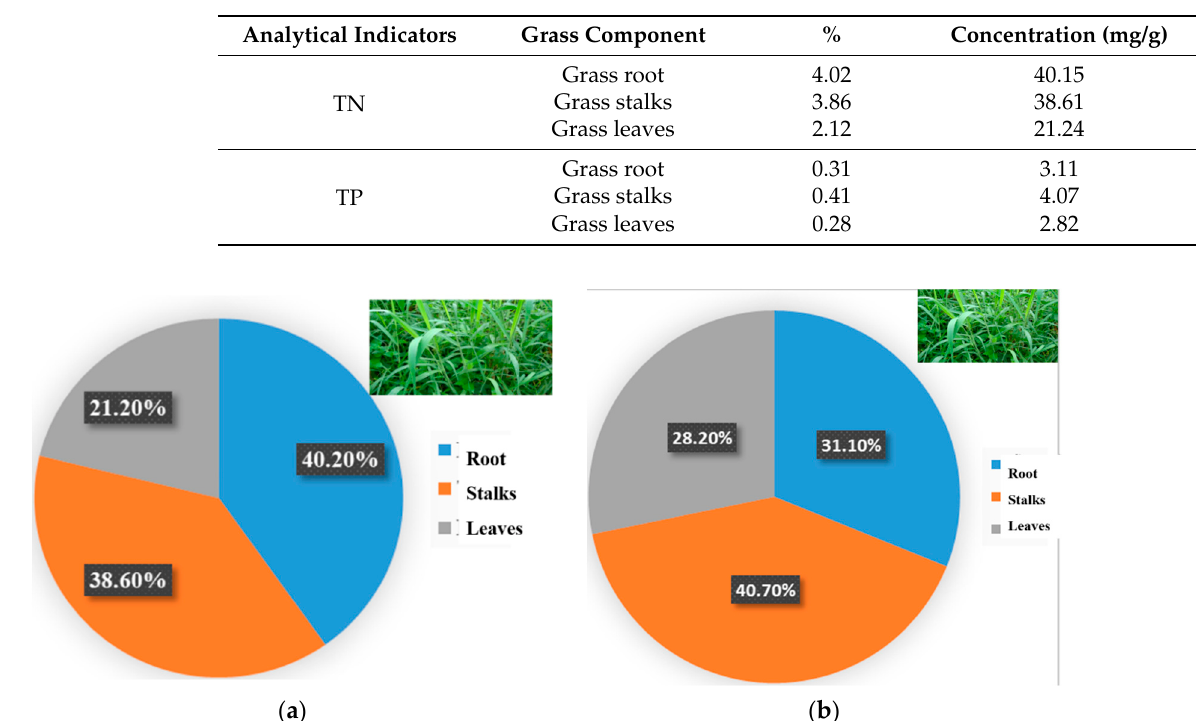
Figure 8. This is a Figure for TN and TP content in the Para grass, they should be listed as: ( a ) accu- mulated TN content; ( b ) accumulated TP content.